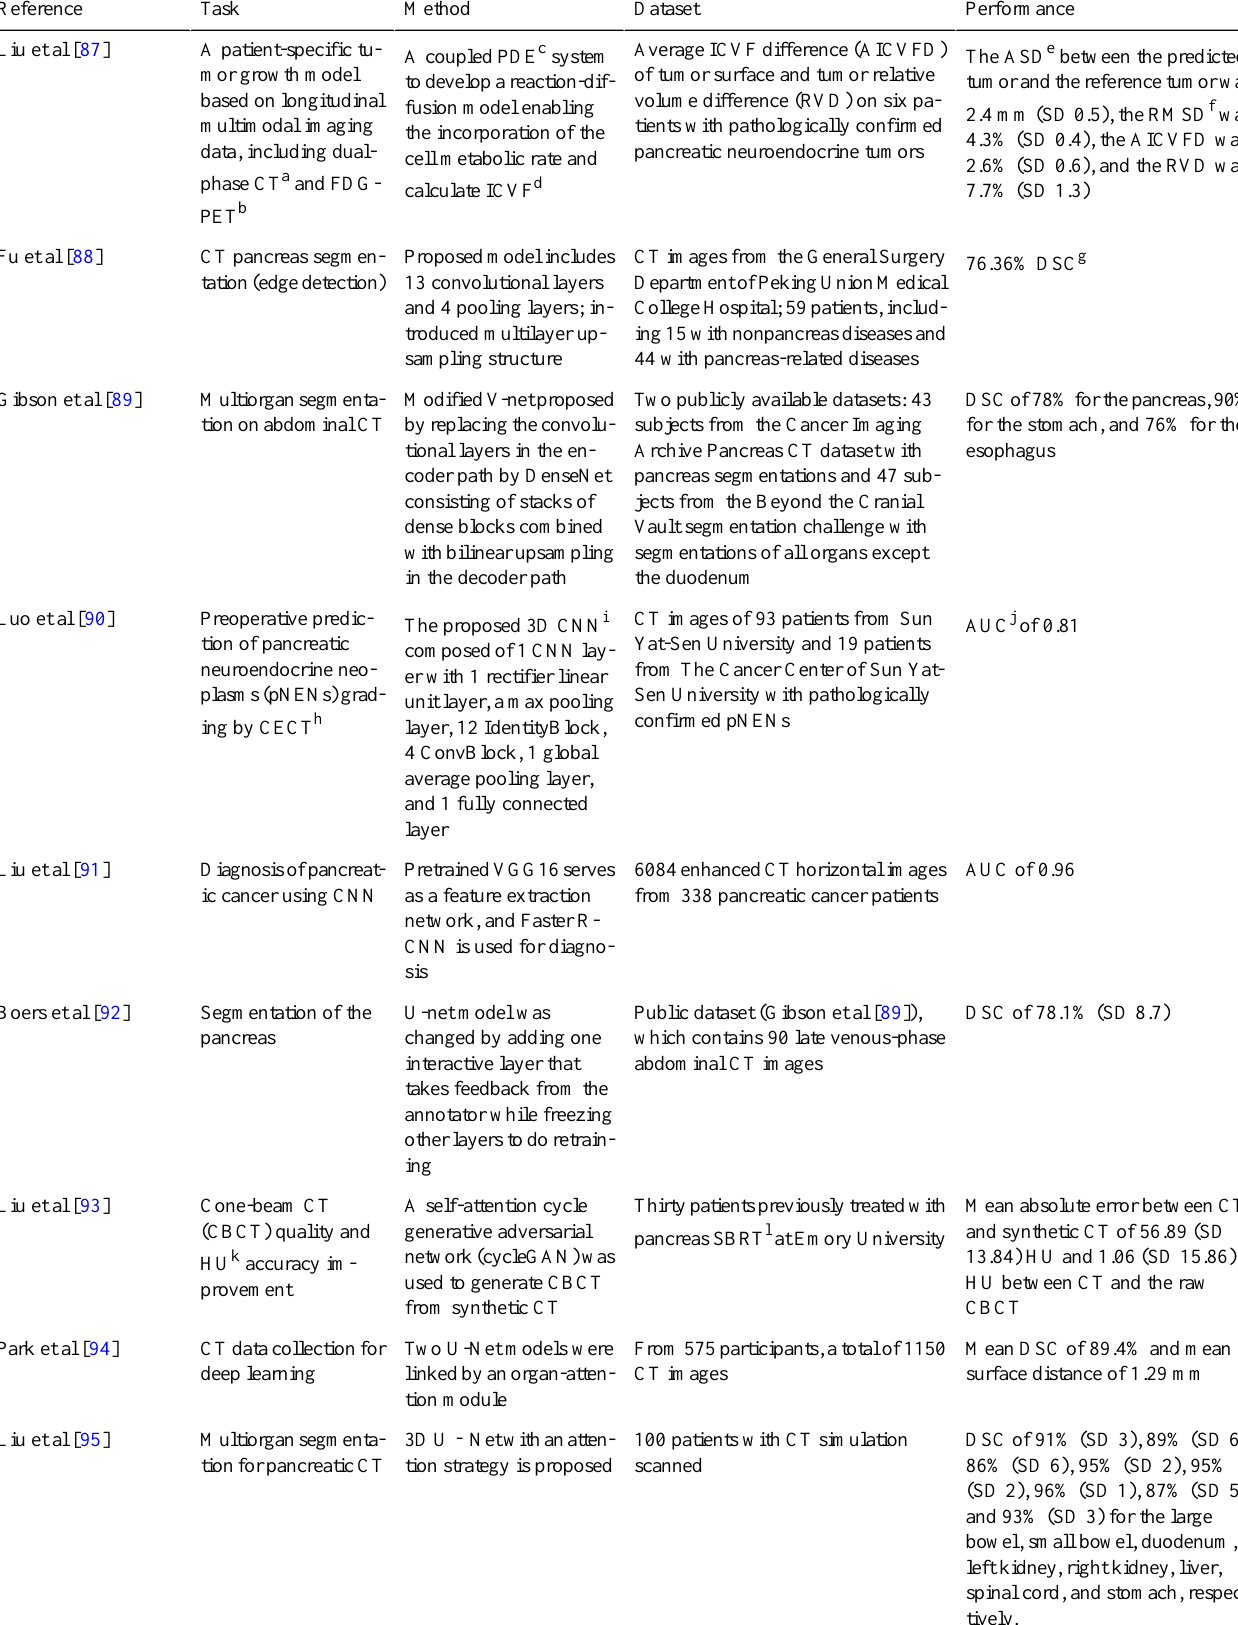
Table 3. Review of published applications of artificial intelligence for pancreatic ductal adenocarcinoma (PDAC).